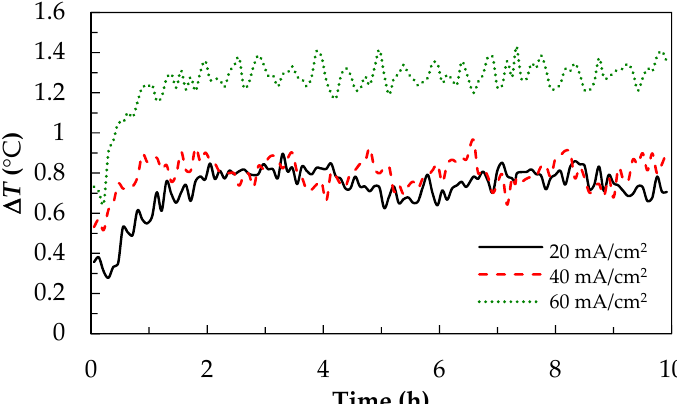
Figure 8. The temperature change ( Δ T ) vs. the charge-discharge cycle time for V/I RFB by Figure 7 charge-discharge conditions with different current density by monitoring of the ITI in: 20 mA/cm 2 , 40 mA/cm 2 and 60 mA/cm 2.